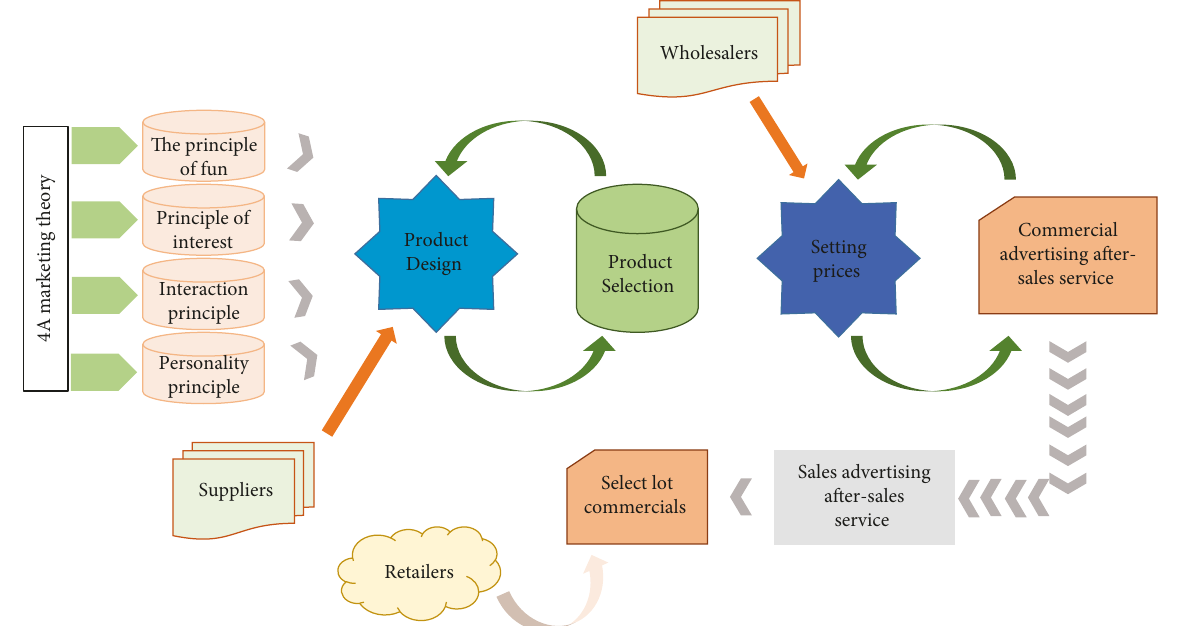
Figure 1: Marketing model of tourism enterprises based on 4A marketing